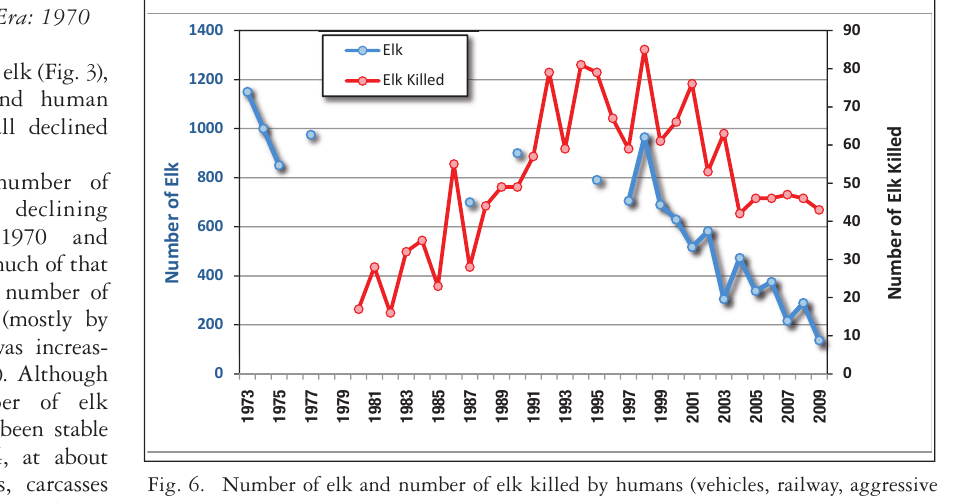
elk) in Jasper National Park from 1973 to